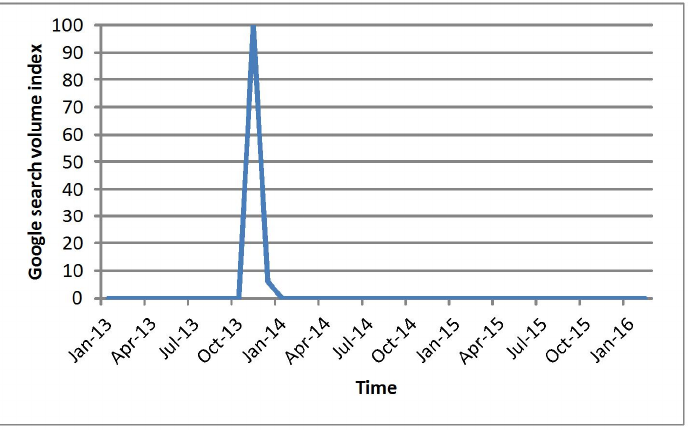
Figure 1. Google Trends data about the “Typhoon Haiyan” event.